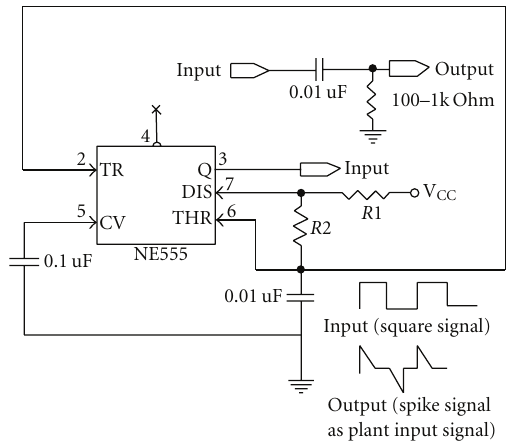
Figure 10: Circuit design for the plant input signal as spike signal.